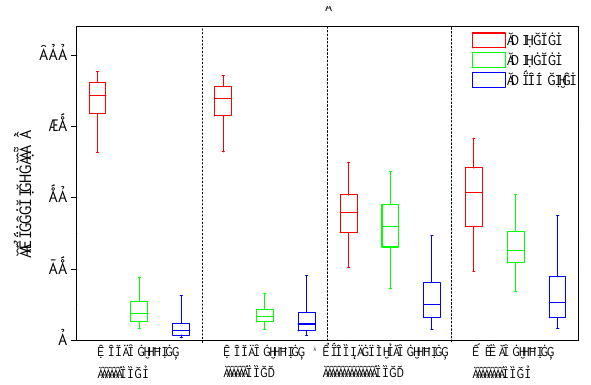
Figure 5. Box and whisker plots of VOC profiles based on different scales during the whole sampling period. Box and whisker plots are constructed according to the 25th–75th and 5th–95th percentiles of the calculation